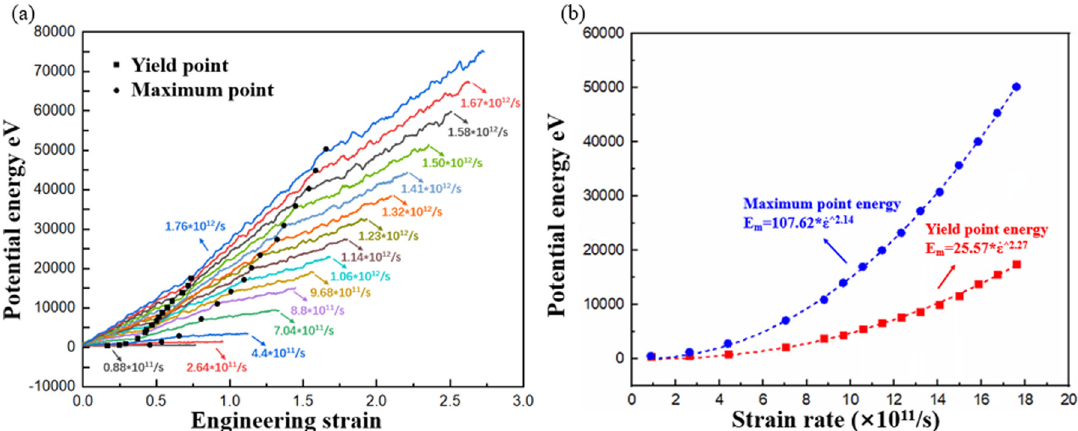
Figure 5: Relation between potential energy and strain rate: ( a ) potential energy with straining at di ff erent strain rates and ( b ) quantitative analysis of strain rate dependencies of the potential energies at yield stress point and maximum stress point.